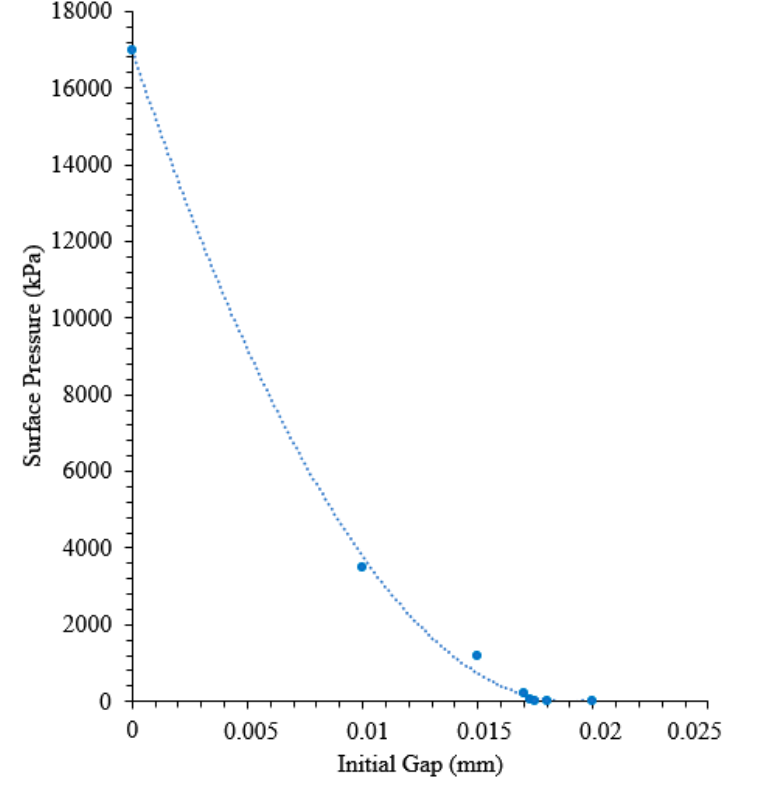
Figure 6. Maximum surface pressure (kPa) as a function of the initial gap between the Al mold and rubber.